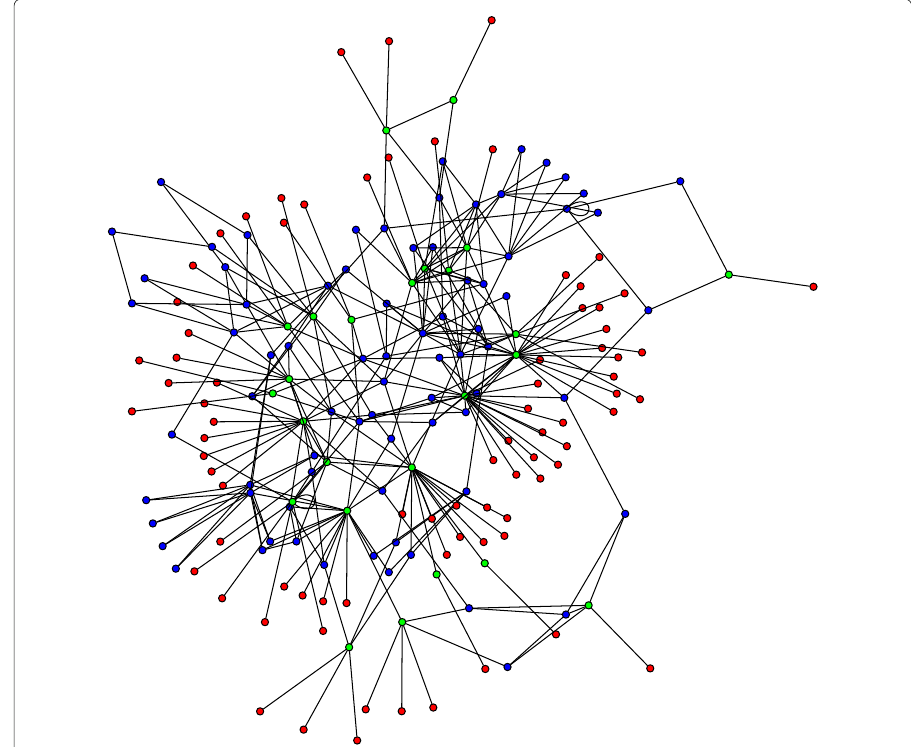
Fig. 2 The topology used in the